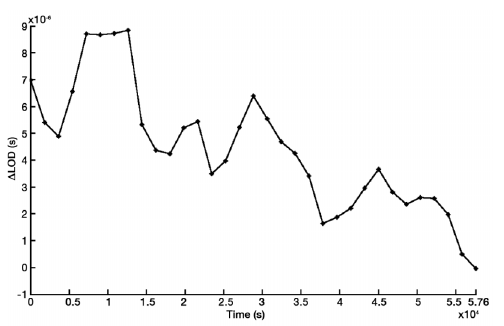
Fig. 6. LOD variation during the 16 h of propaga- tion of the simulated